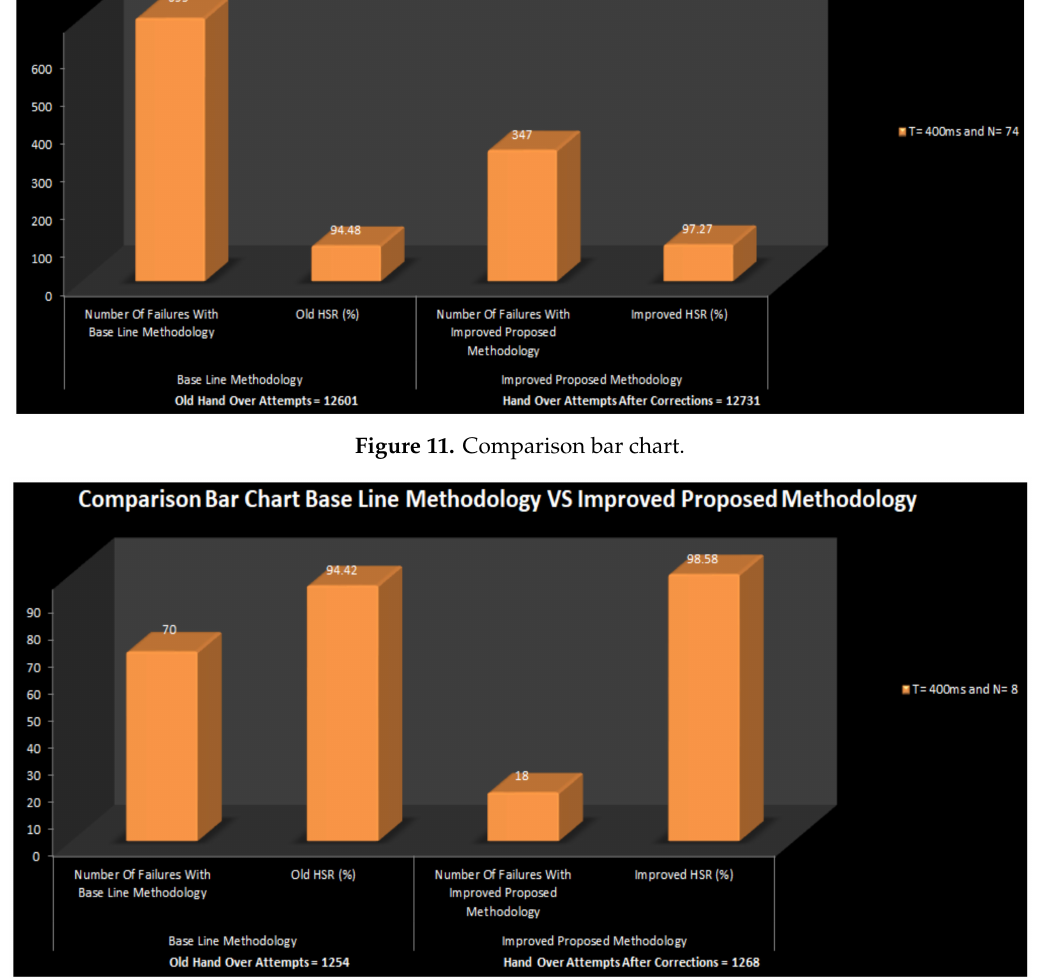
Figure 12. Comparison bar